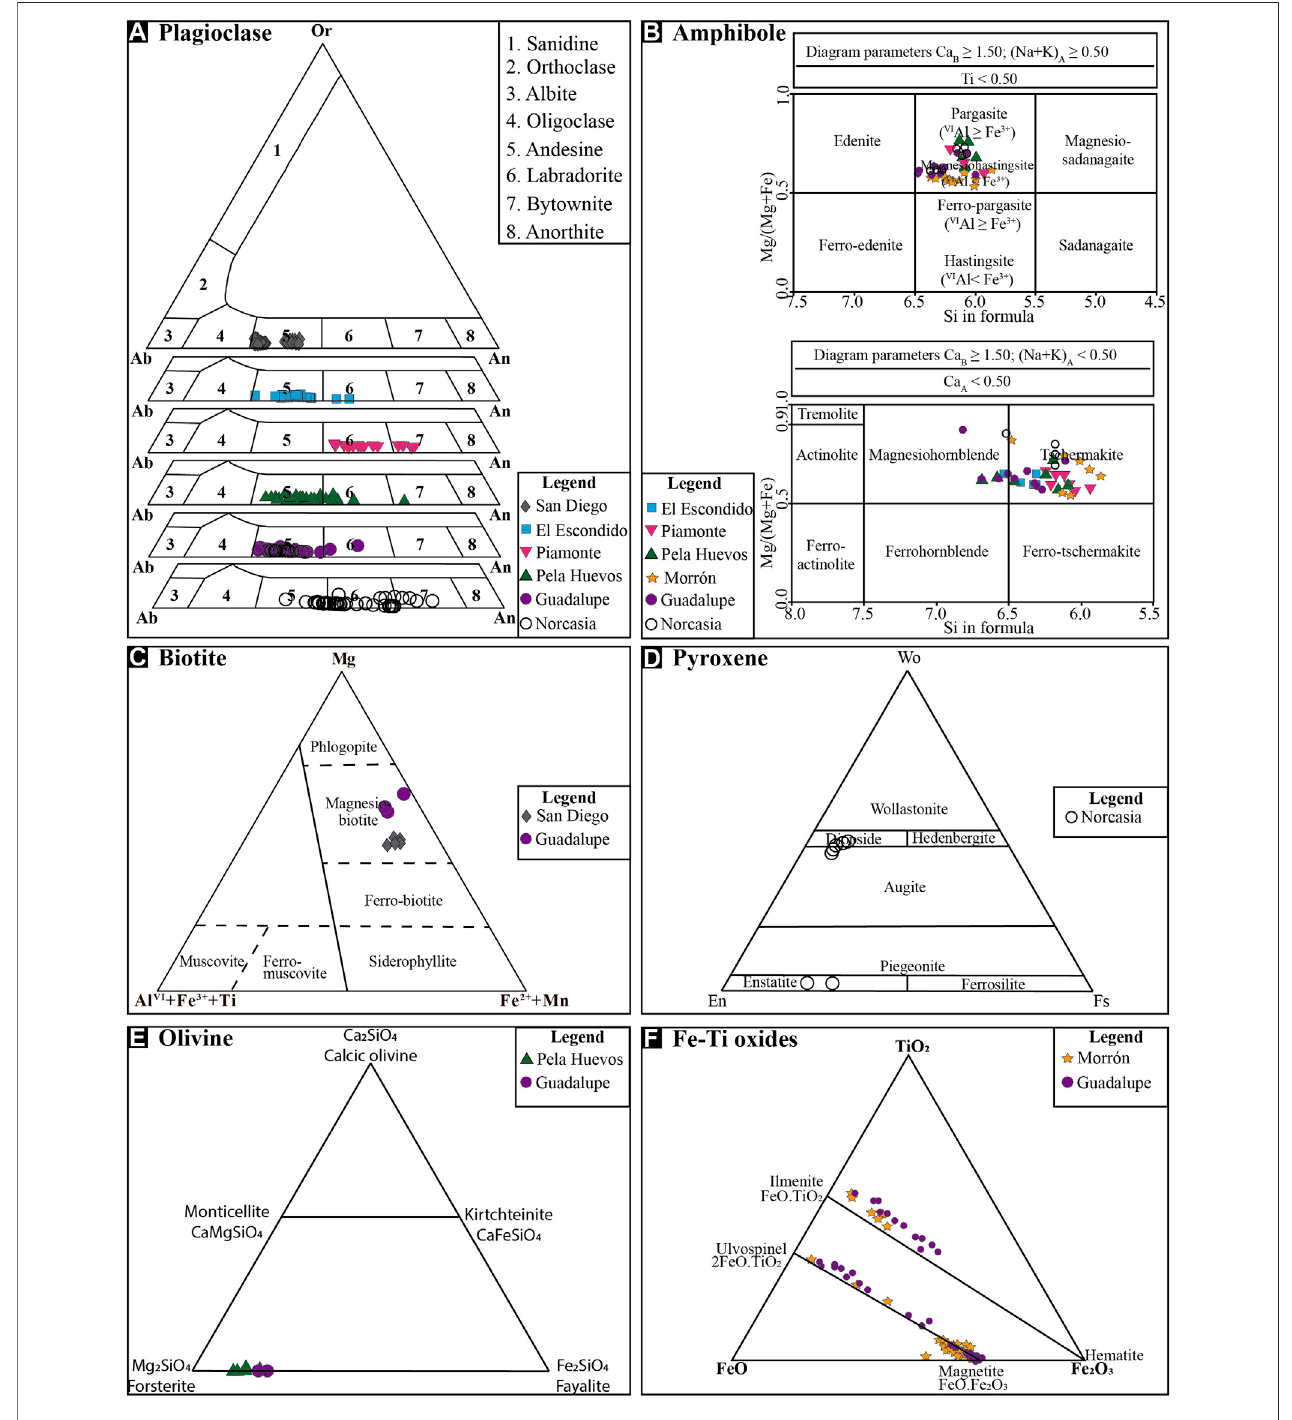
FIGURE 4 | Mineral classi fi cation diagrams. (A) Plagioclase (Rahman & MacKenzie, 1969). (B) Amphibole (Leake et al., 1997). (C) Biotite (Foster, 1960). (D) Pyroxene (Morimoto, 1989). (E) Olivine. (F) Fe – Ti oxides (after Parat et al., 2005).